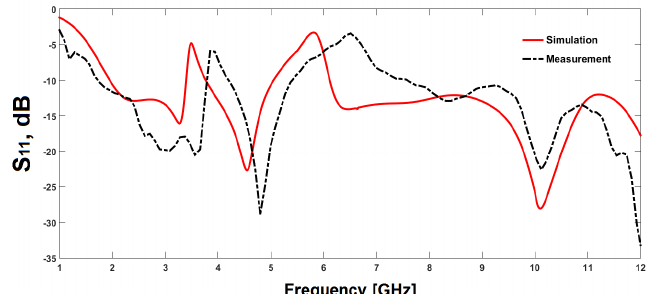
Figure 13: Measured and simulated S 11 of the proposed dual band-notch